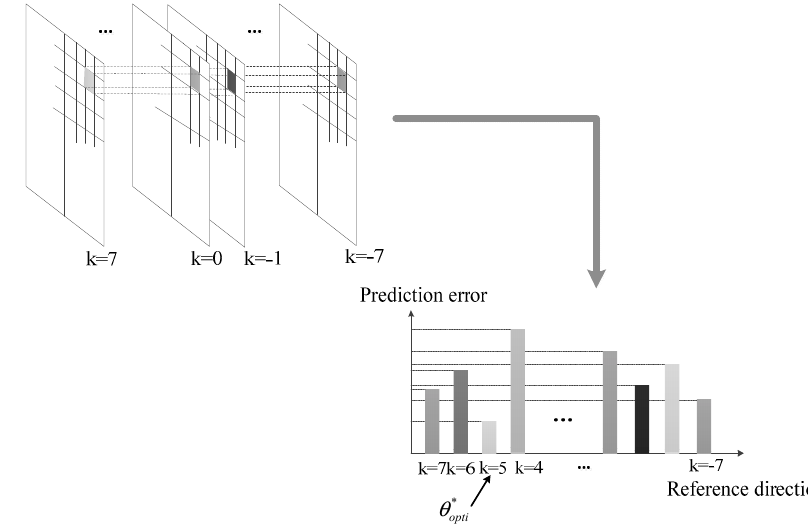
Figure 4. The process of calculating the optimal prediction direction of a block.